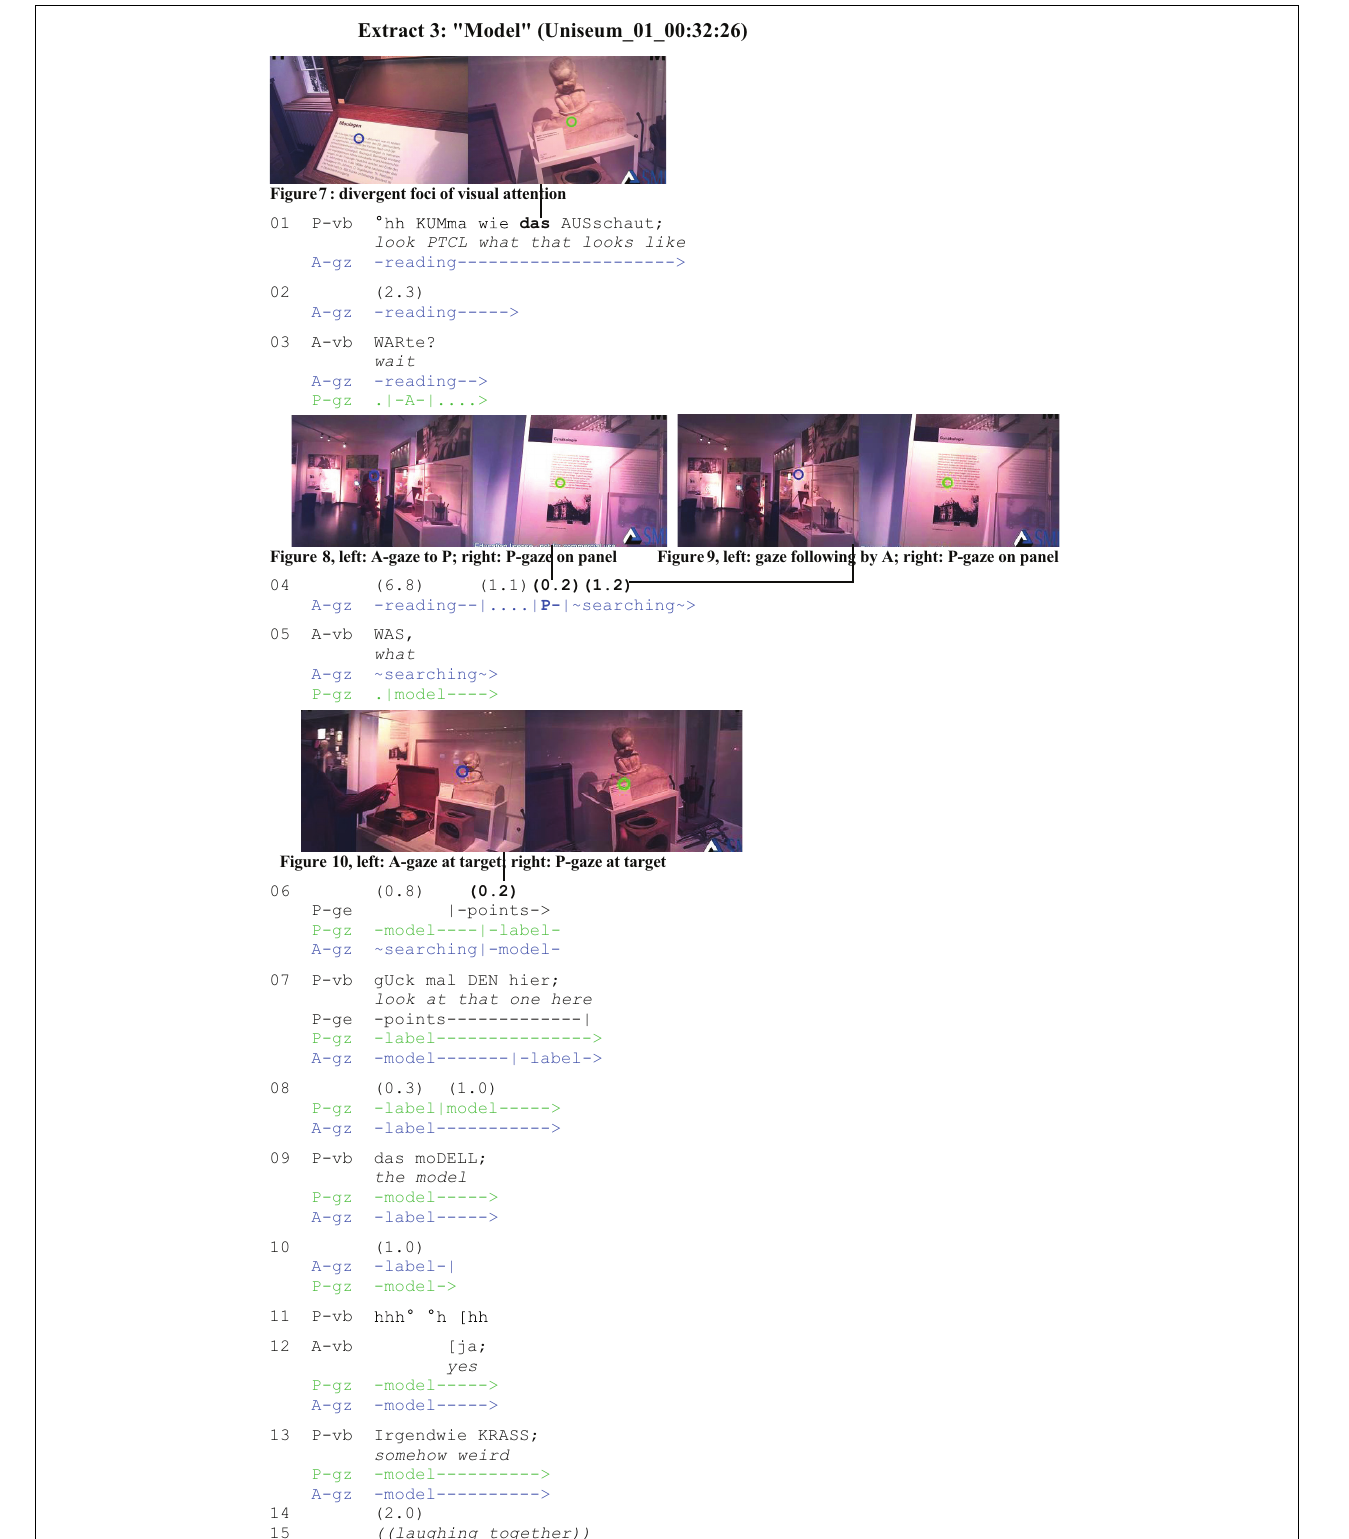
Figure 7: divergent foci of visual attention